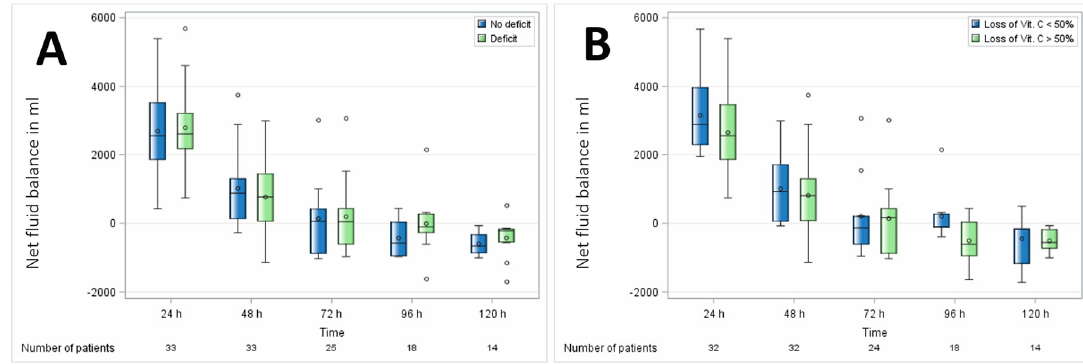
Figure 7. Association of perioperative vitamin C levels with fluid balance. ( A ) Patients with preoperative vitamin C deficit and ( B ) patients with intraoperative loss of vitamin C ≥ 50%. N, number of patients. Circles represent outliers.